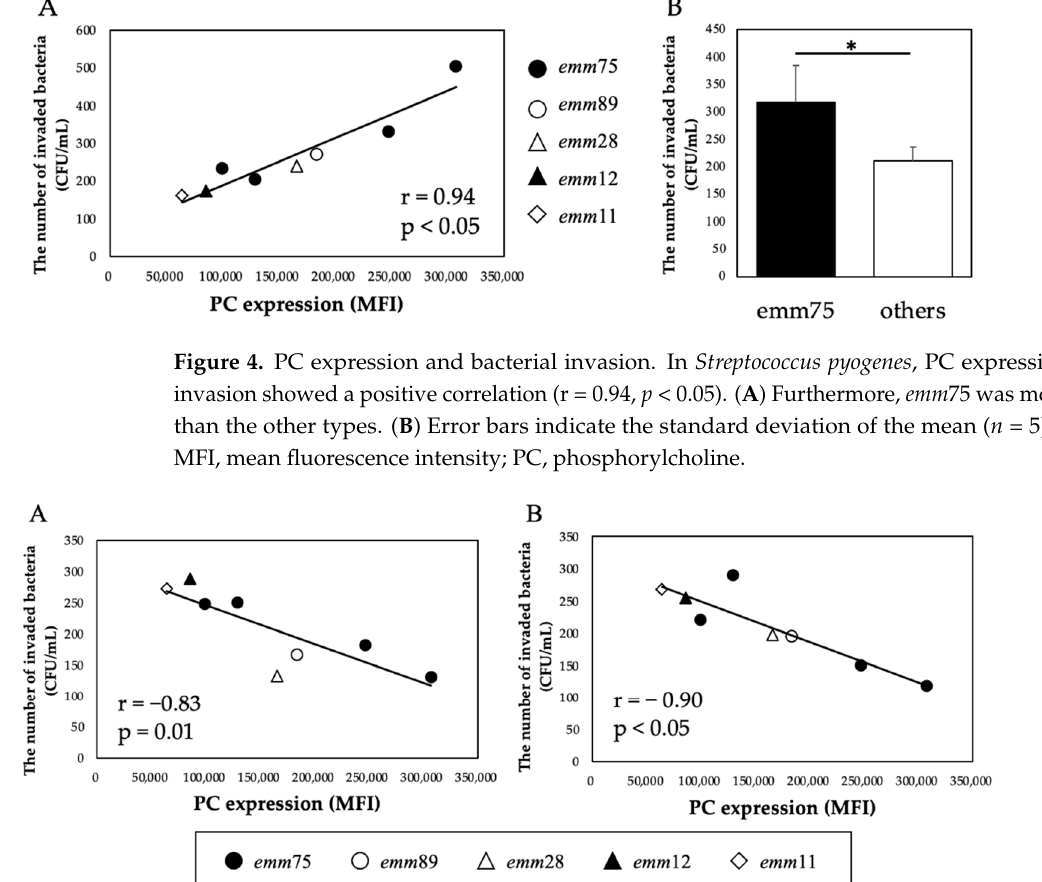
Figure 4. PC expression and bacterial invasion. In Streptococcus pyogenes, PC expression and cell invasion showed a positive correlation (r = 0.94, p < 0.05). ( A ) Furthermore, emm 75 was more inva- sive than the other types. ( B ) Error bars indicate the standard deviation of the mean ( n = 5). * p < 0.05. MFI, mean fluorescence intensity; PC, phosphorylcholine.